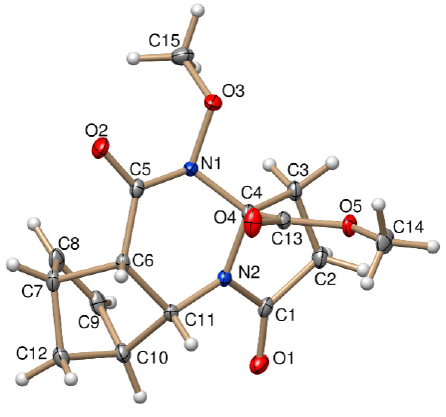
Figure 1. Oak Ridge Thermal Ellipsoid Plot (ORTEP) plot of the X-ray structure of ( ± )- 3a .